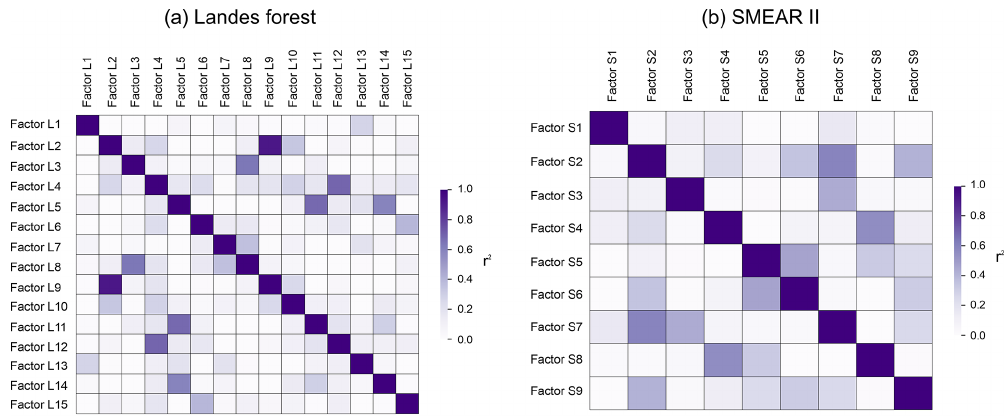
Figure 11. The correlations among various factors identified (a) in the Landes forest and (b) at the SMEAR II station, with the color representing the correlation coefficients ( r 2